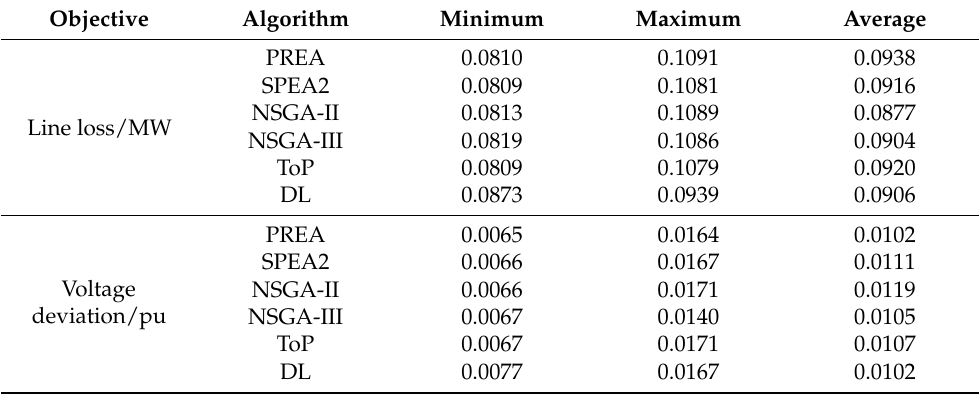
Table 4. Statistical results of PFs obtained in the IEEE 33-bus